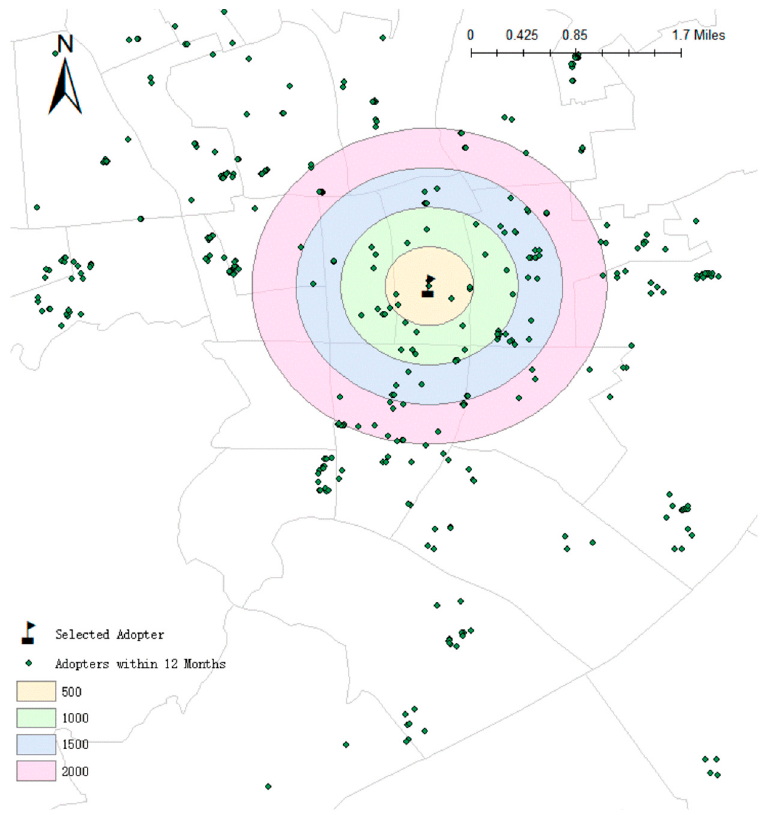
Figure 4. Selection of all neighbor adopters within 12 months.